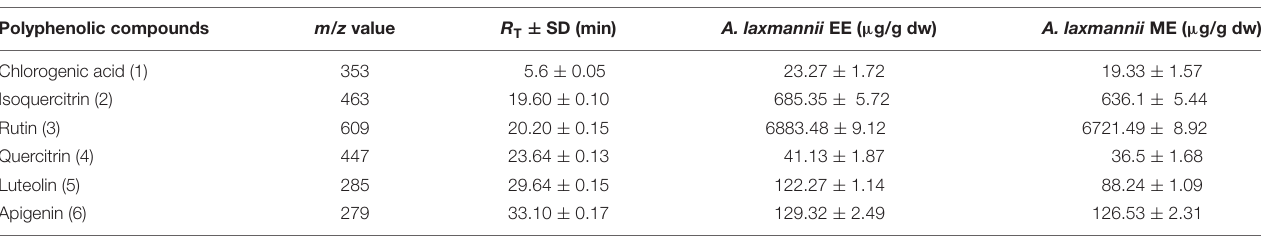
Values are the mean ± SD (n = 3).